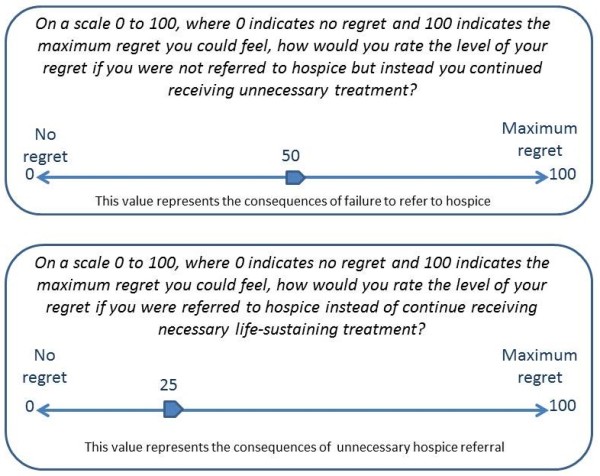
DVAS (Dual Visual Analogue Scales). The DVAS are used for the elicitation of the decision maker's threshold probability.